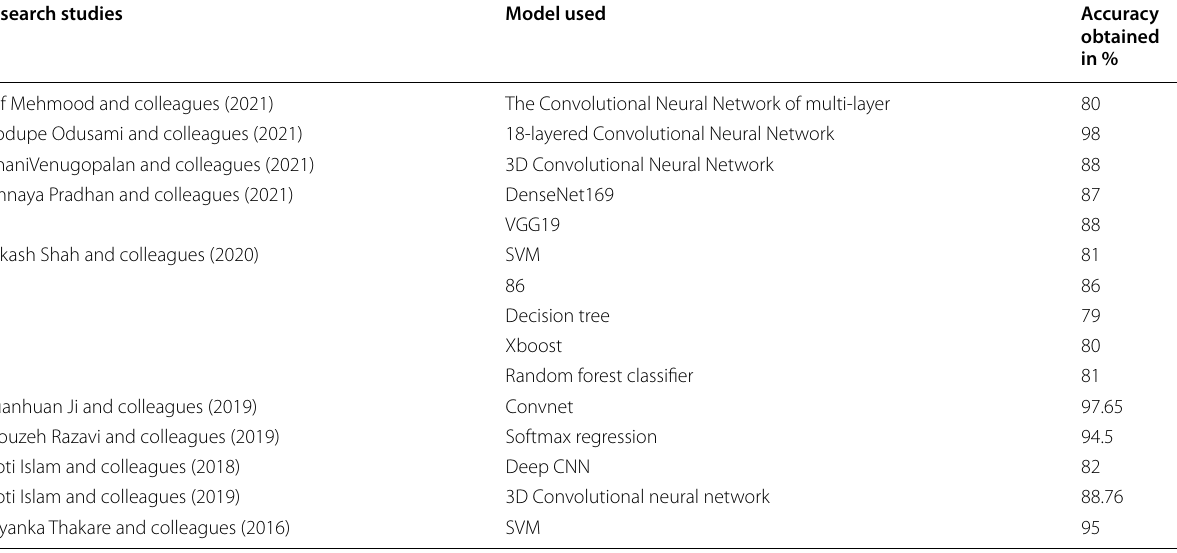
Table 3 List of accuracies obtained for the related research studies